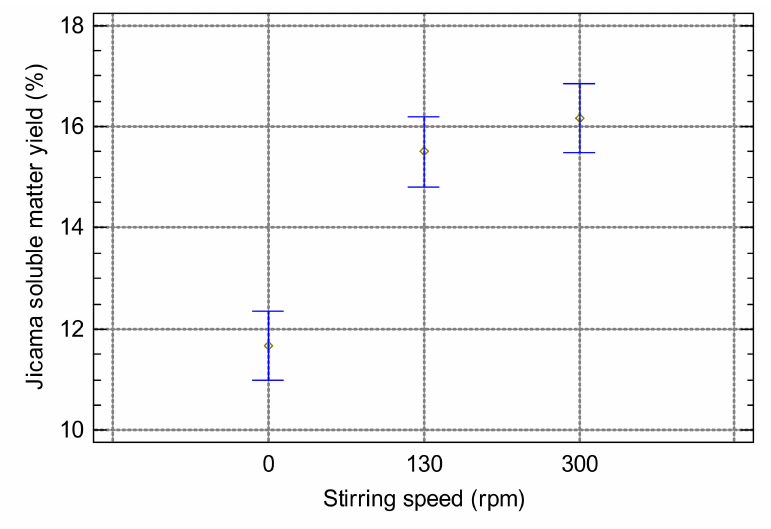
Figure A1. Results of Fisher’s LSD test ( P < 0.05) for jicama soluble matter yield as a function of extraction stirring speed.